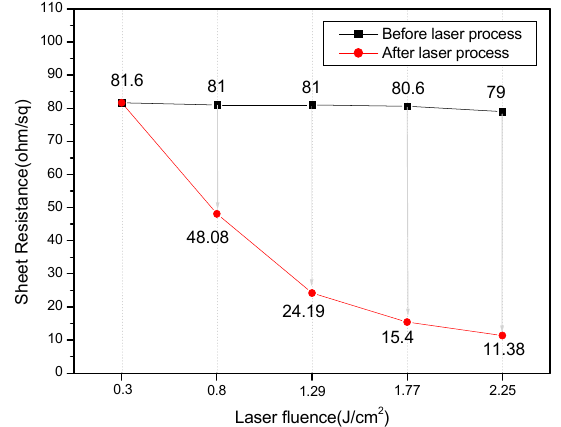
Figure 4. Sheet resistance of the emitter layer and its decreasing magnitude versus laser